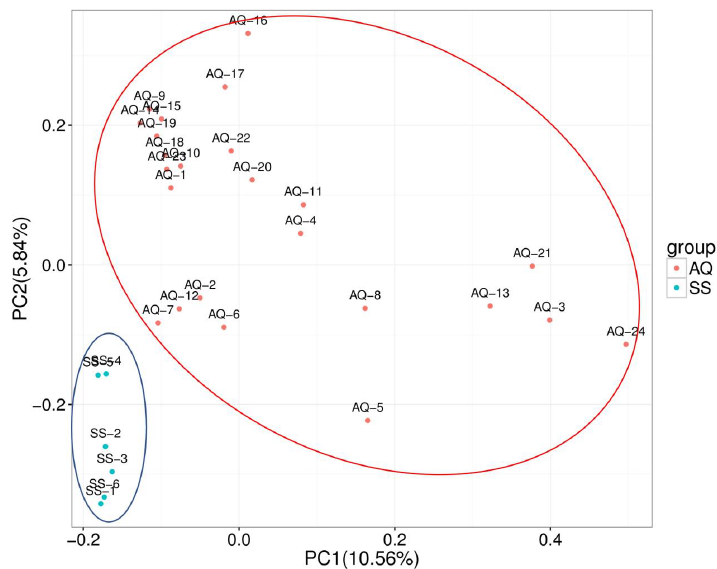
Figure 2. Principal component analysis (PCA) for the two main components of 30 individuals in two populations; pink nodes and light blue nodes represent the AQ and SS groups, respectively.